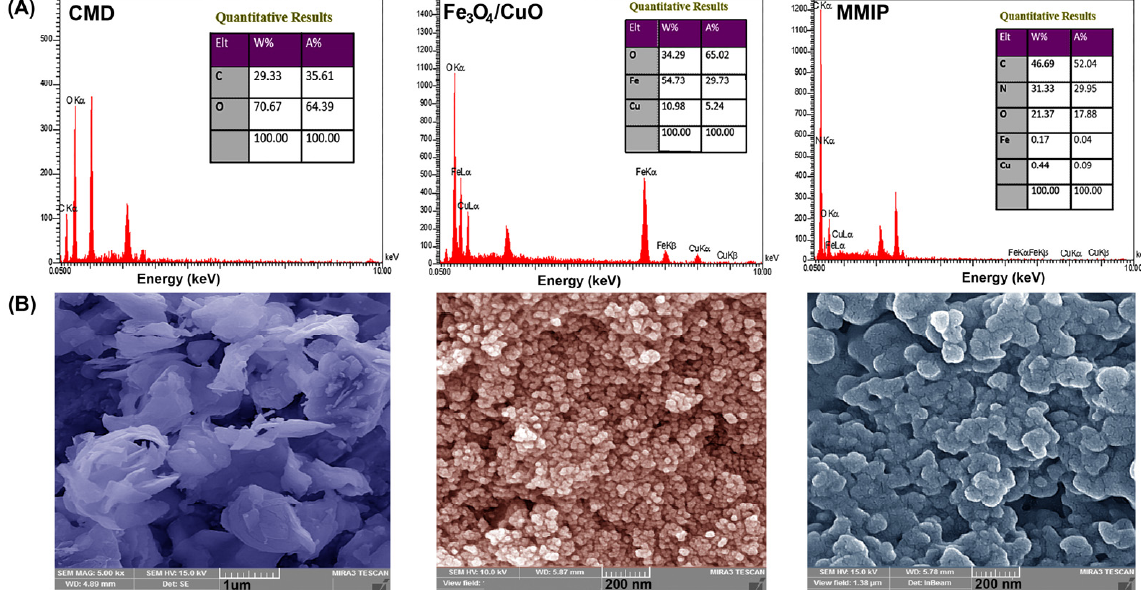
Figure 3. EDX spectra and tabulated data ( A ) and FESEM images ( B ) of carboxymethyl dextrin (CMD), Fe 3 O 4 /CuO, and magnetic molecularly imprinted polymer (MMIP). VSM : The magnetic characteristics of Fe 3 O 4 /CuO nanoparticles and MMIP were in